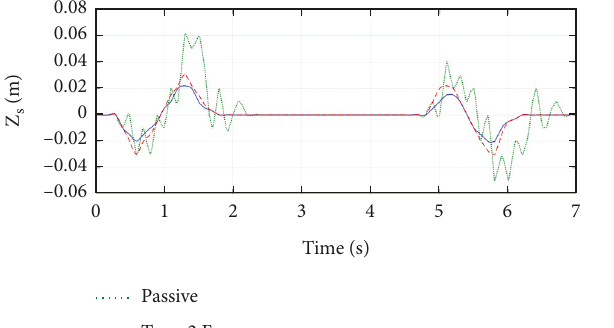
Figure 10: Control signal.